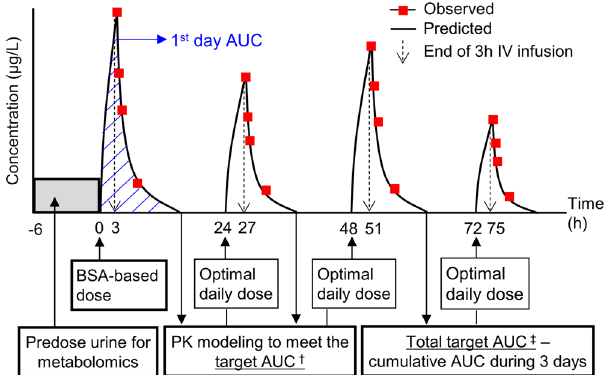
Figure 6. Dosing regimen scheme of busulfan in hematopoietic stem cell transplantation (HSCT) patients. Busulfan was administered once daily for 4 consecutive days and the area under the curve (AUC) was predicted from the pharmacokinetic (PK) modelling results. The solid line represents the predicted concentrations and open circles represent the observed concentrations at the sampling time (1, 2, and 4 h after the respective doses). According to the calculated AUC, the optimal dose was adjusted to meet the target AUC. † 18,000– 19,000 μ g∙h/L/day, ‡ Sum of the AUC during 4 days (74,000 μ